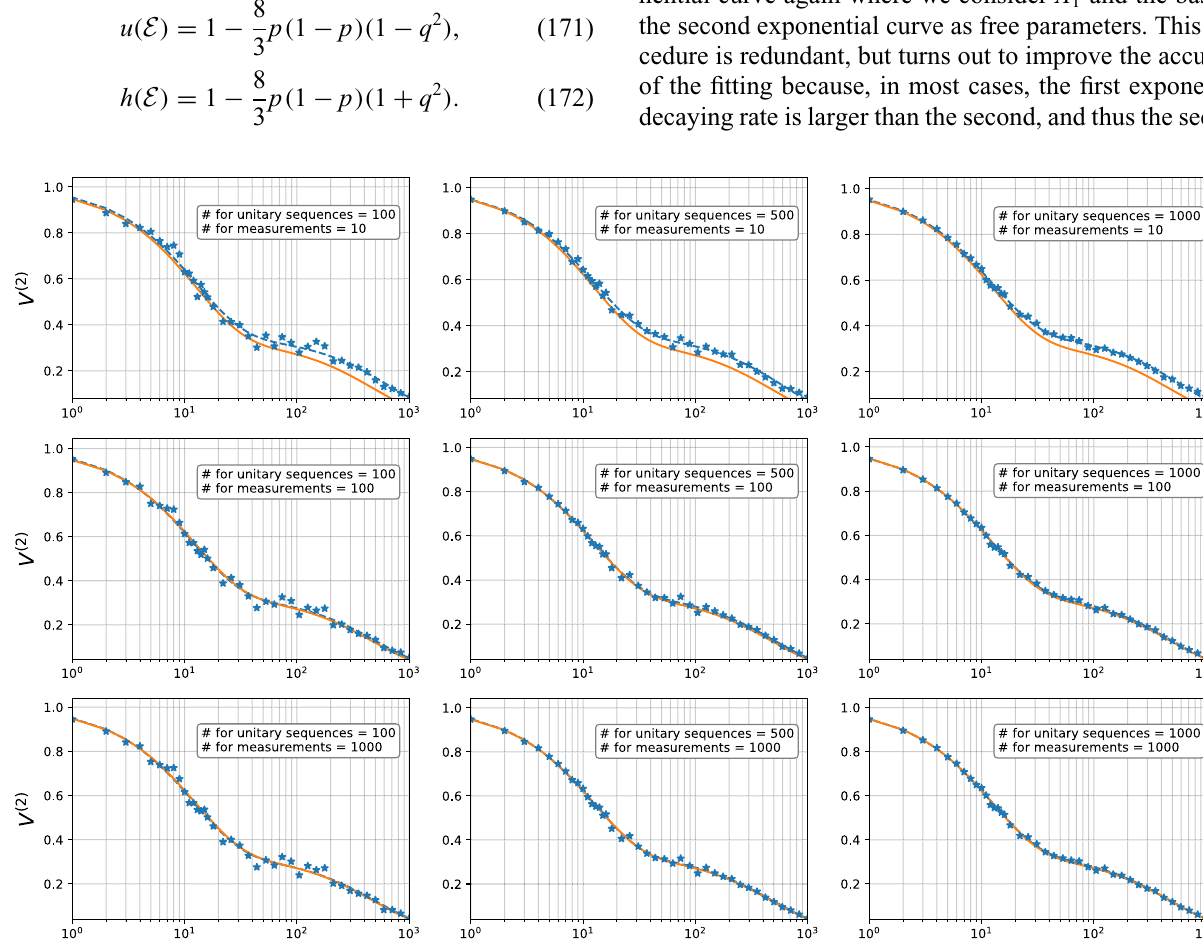
FIG. 6. Numerical results for the single-qubit 2-RB with various numbers of samplings for measurement and those for unitary sequences when the noise parameters are set to p = q = 0.02. The dots correspond to the values of V ( 2 ) obtained from the given numbers of samplings for measurement and for unitary sequences, and the dashed lines are fitting results. Theoretical values are shown in the solid